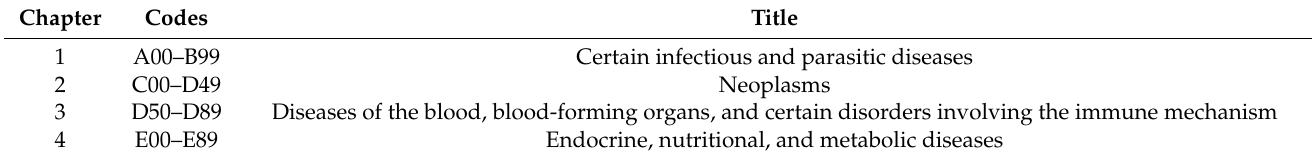
Table A1. Chapter-wise grouping of diagnosis codes for ICD-10 CDC